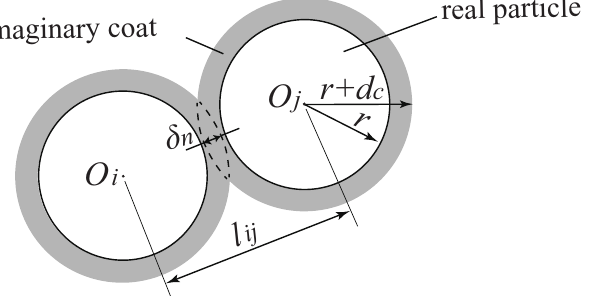
Figure 3. Sketch of the ICA. Solid circles show two same-sized real particles and gray parts are the imaginary coats, where d c > δ n . The thickness of the imaginary coats, d c , is much greater than the maximum overlap, δ n , in the